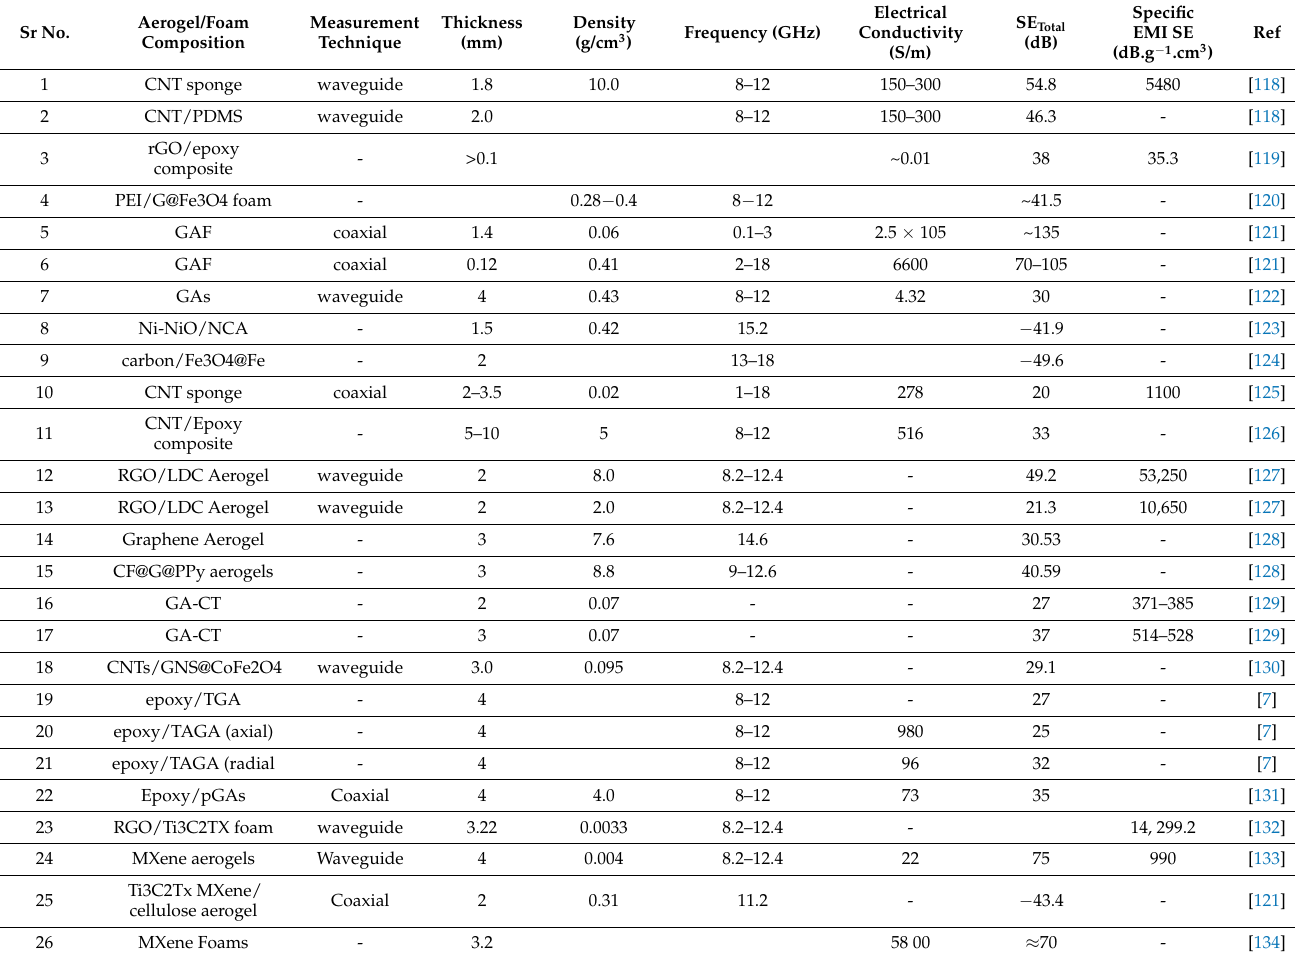
Table 2. Measurement technique, shield thickness (mm), frequency (GHz), electrical conductivity (S/m), SE Total (dB) and specific EMI SE (dB.g − 1 .cm 3 ) of some porous nanocomposites reported in the